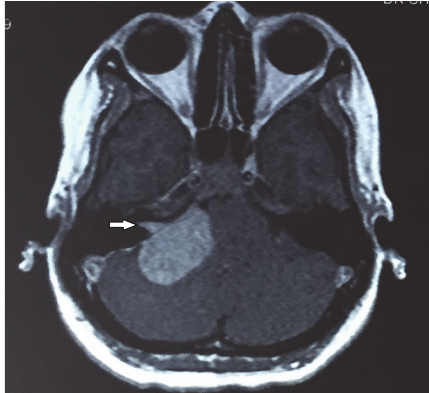
Figure 4: Contrast axial MRI shows the extension of the tumor into the internal auditory canal represents “shark fin” appearance (white arrow).